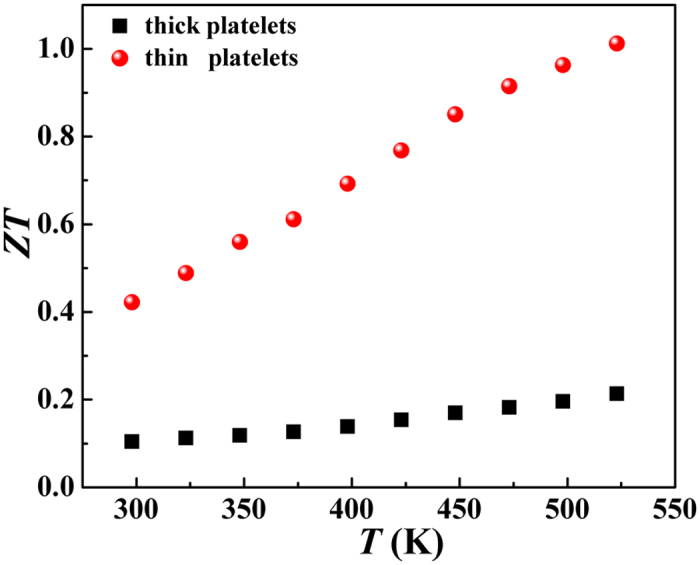
Temperature dependence of dimensionless figure of merit for Sb2Te3 thin and thick platelets.